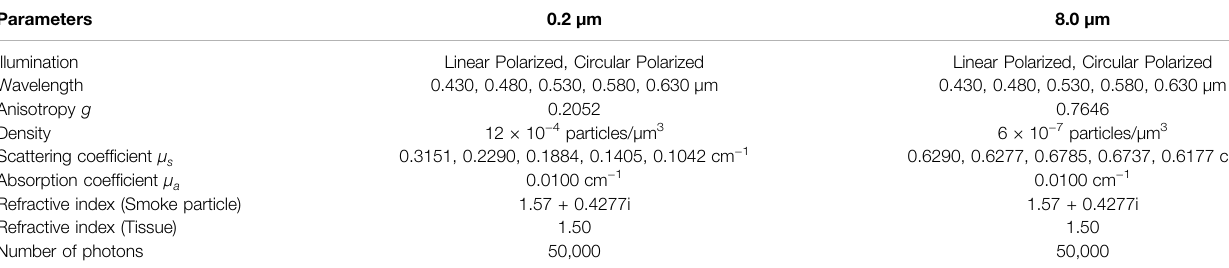
TABLE 2 | Simulation parameters of medium with different wavelengths.